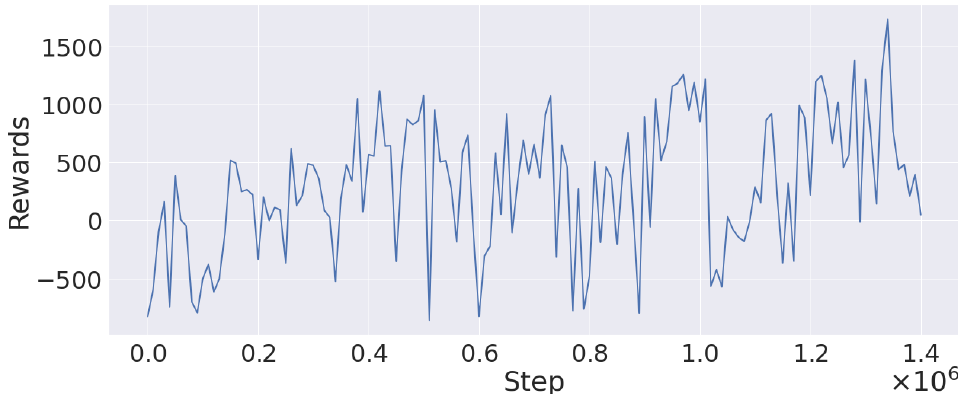
Figure 9. Rewards obtained by the SAC agent.